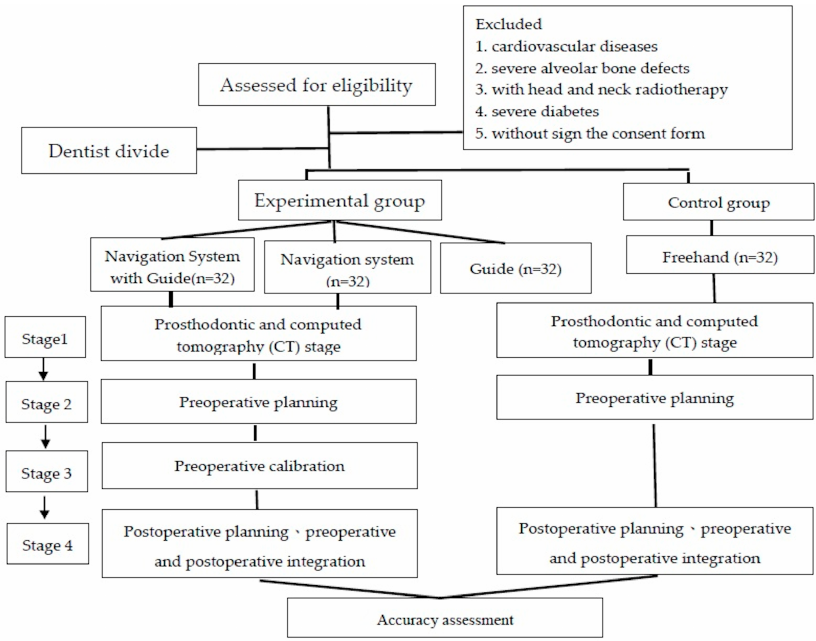
Figure 1. The workflow of participant recruitment and operational processes for four approaches. Int. J. Environ. Res. Public Health 2020 , 17 ,